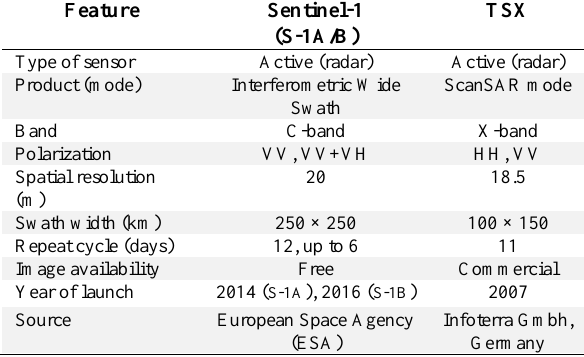
Table 1. Operational features of the SAR data used in the generation of the rice planting window in the Philippines.